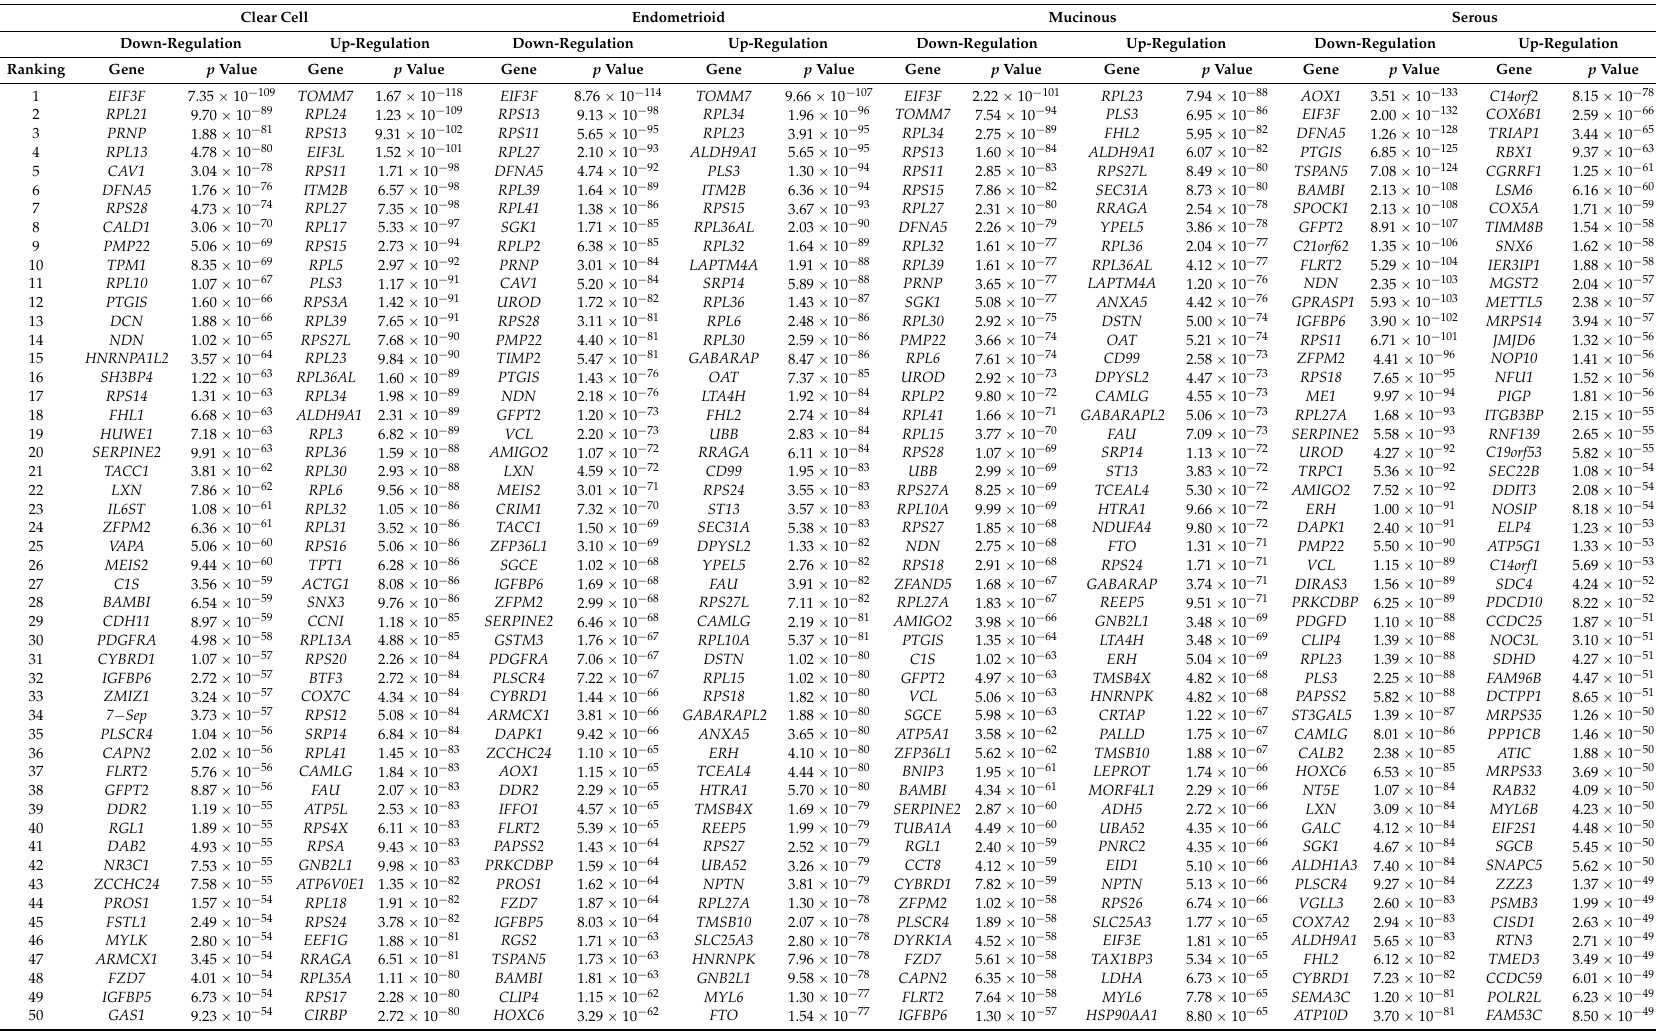
Table 5. The top 100 up- and down-regulated differentially expressed genes of the four EOC subtype groups. The genes were ranked by their p values. ClearCell Endometrioid Mucinous Serous Down-Regulation Up-Regulation Down-Regulation Up-Regulation Down-Regulation Up-Regulation Down-Regulation Up-Regulation